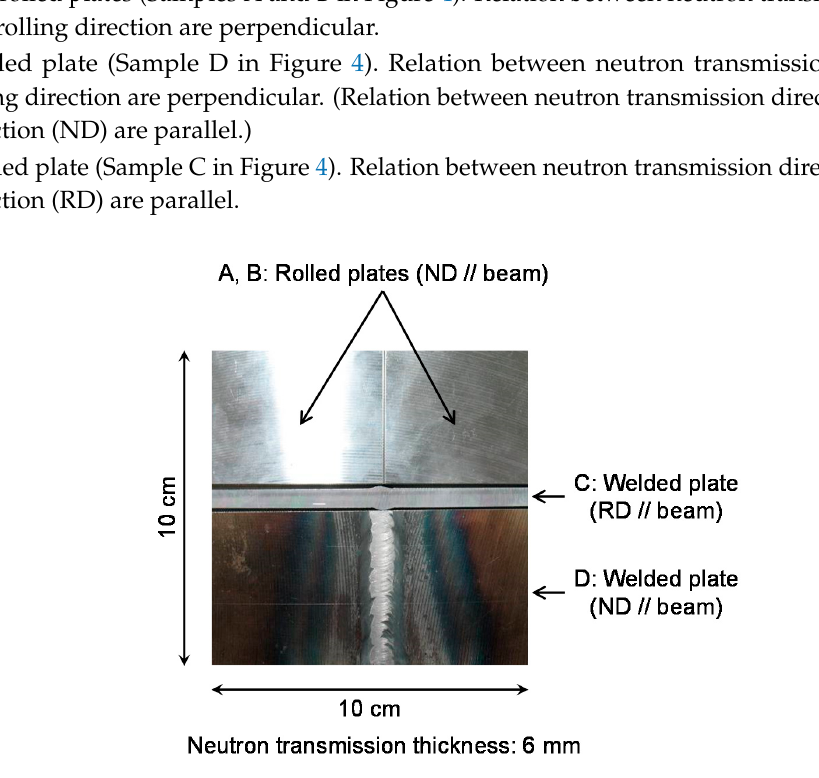
Figure 4. Photograph of rolled/welded α -iron specimens for demonstration of quantitative